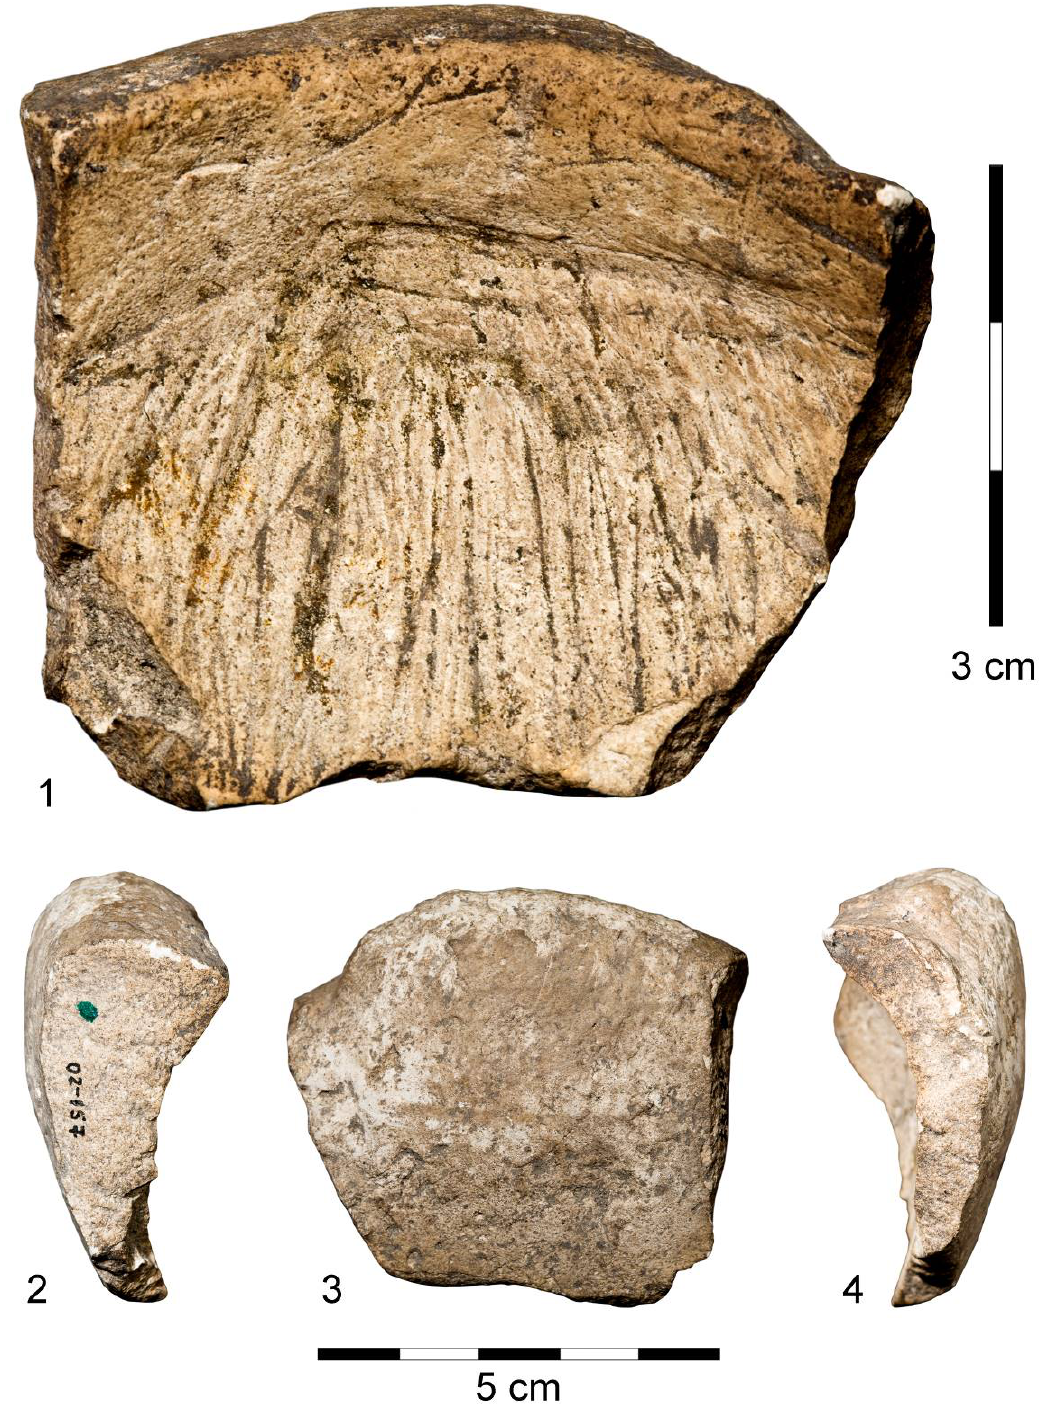
Figure 4. A soft limestone bowl fragment from Loc. 13. 1) top view; 2, 4) profiles; 3) bottom